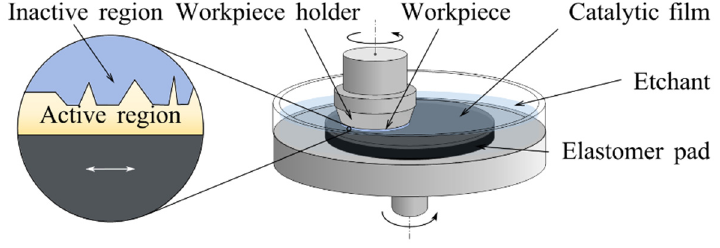
Figure 14. The schematic diagram of a CARE